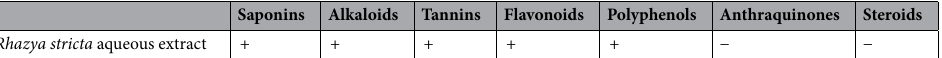
Saponins Alkaloids Tannins Flavonoids Polyphenols Anthraquinones